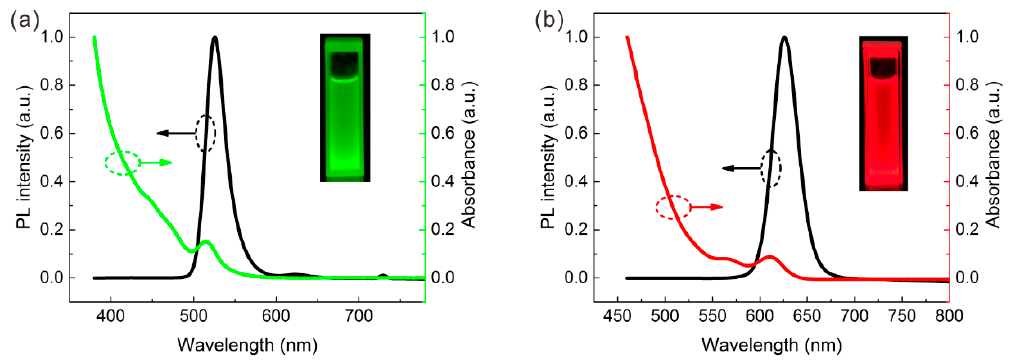
Figure 1. Photoluminescence (PL) and absorbance spectrum of ( a ) GQDs and ( b ) RQDs.